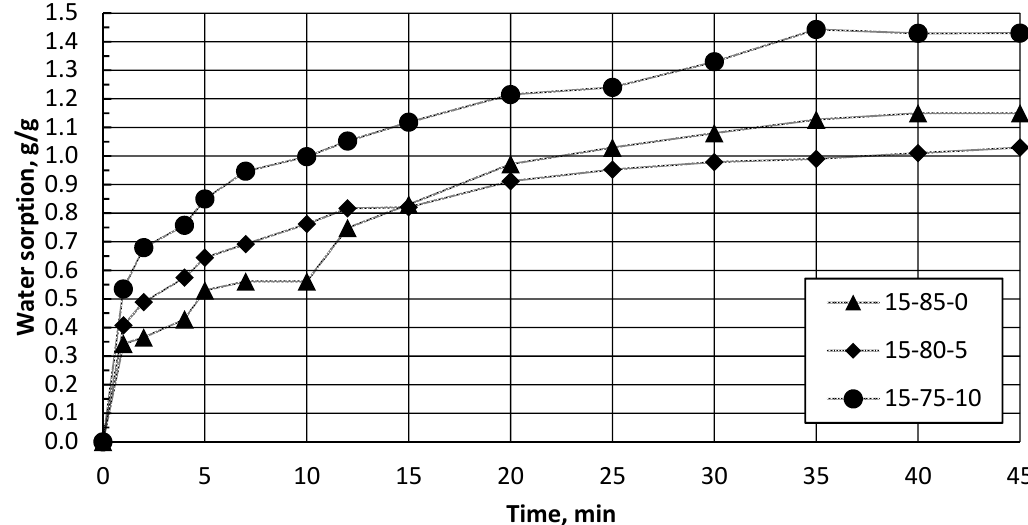
Figure 10. Water adsorption, in g/g for granules compositions series with 0 wt.% (15–85–0), 5 wt.% (15–80–5), and 10 wt.% (15–75–10) of CS.